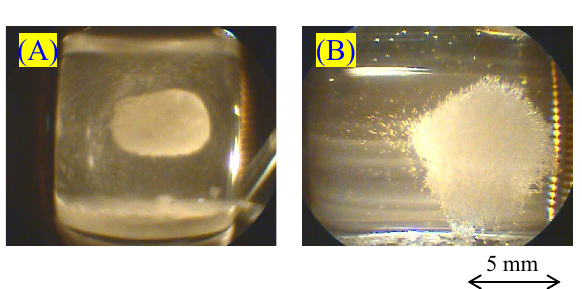
Figure 5. The contactless crystallization results verified the reproducibility. ( a ) Used the type A booster, and ( b ) used the type B booster. The spherical shell crystallization was reproduced only once, in ( a ). It is